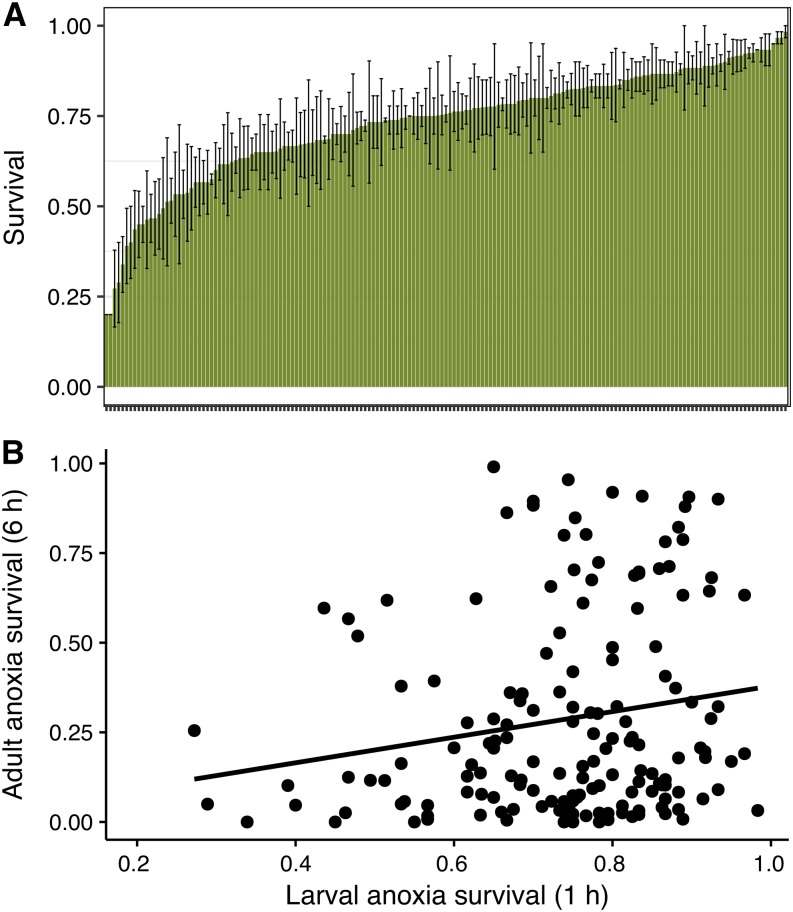
Larval anoxia phenotype showing A) mean survival ± SE for each line after 1 h of anoxic exposure. B) Larval survival was significantly, but not strongly correlated to adult survival pooled by sex (r = 0.18, P = 0.02).